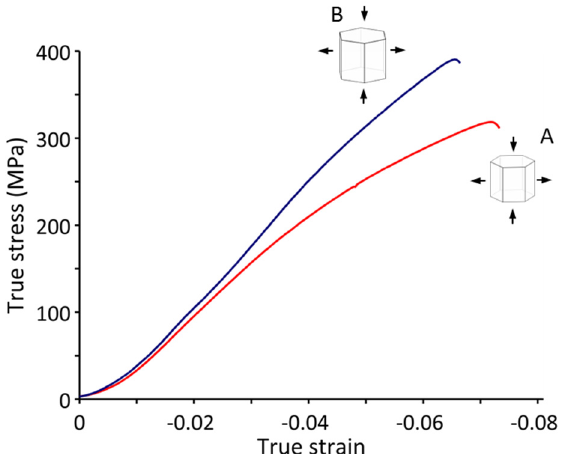
Figure 4. Flow curves of pure Mg single crystals of orientations A and B ( c -axis contraction) deformed by PSC at ambient temperature and a constant strain rate of 10 − 3 s − 1 . Oil was used for lubrication.